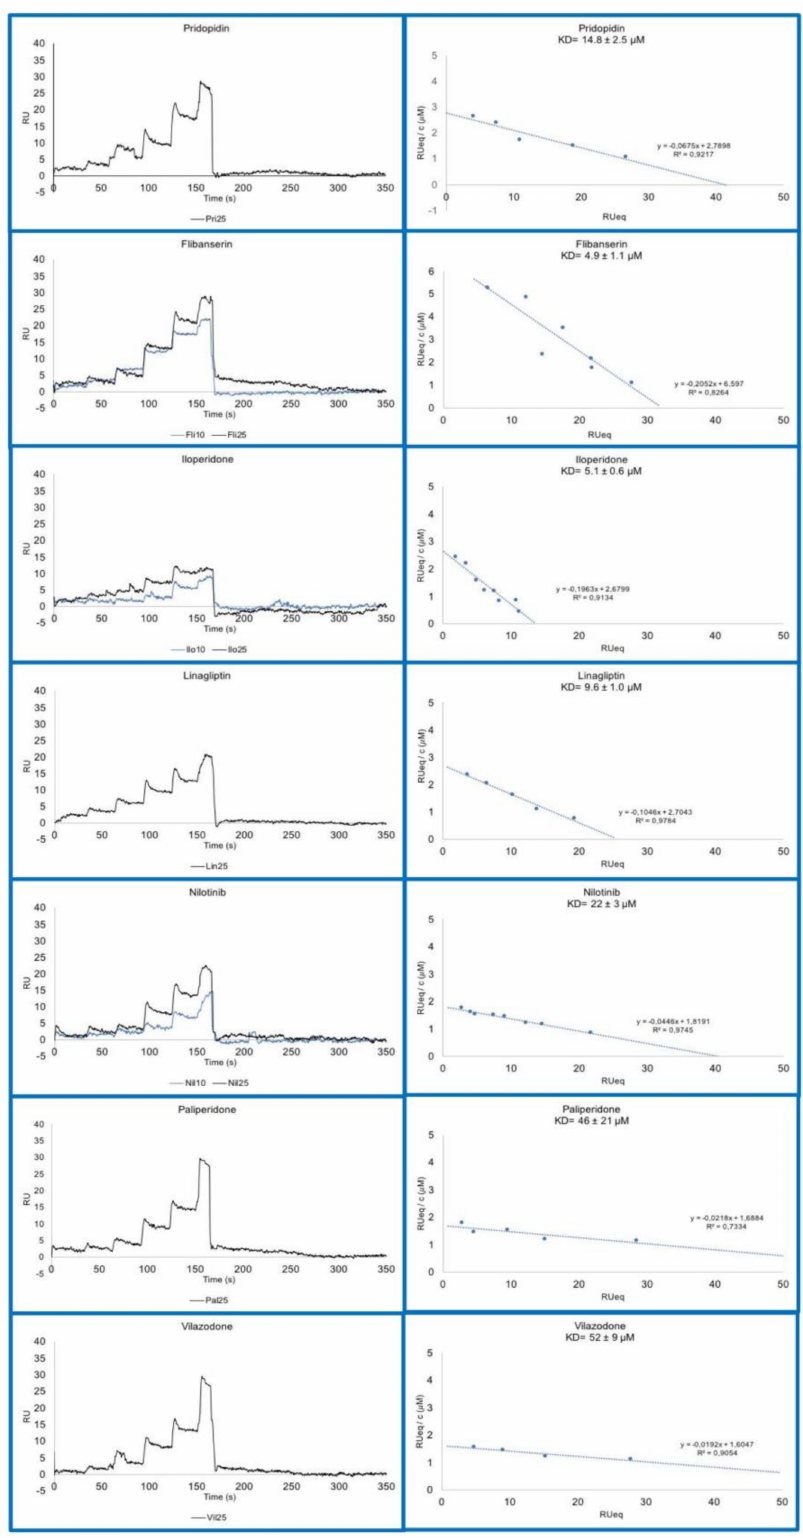
Figure 4. Sensorgrams ( left ) and Scatchard plot analyses ( right ) of compounds selected by virtual screening and computational docking, and of pridopidine as a